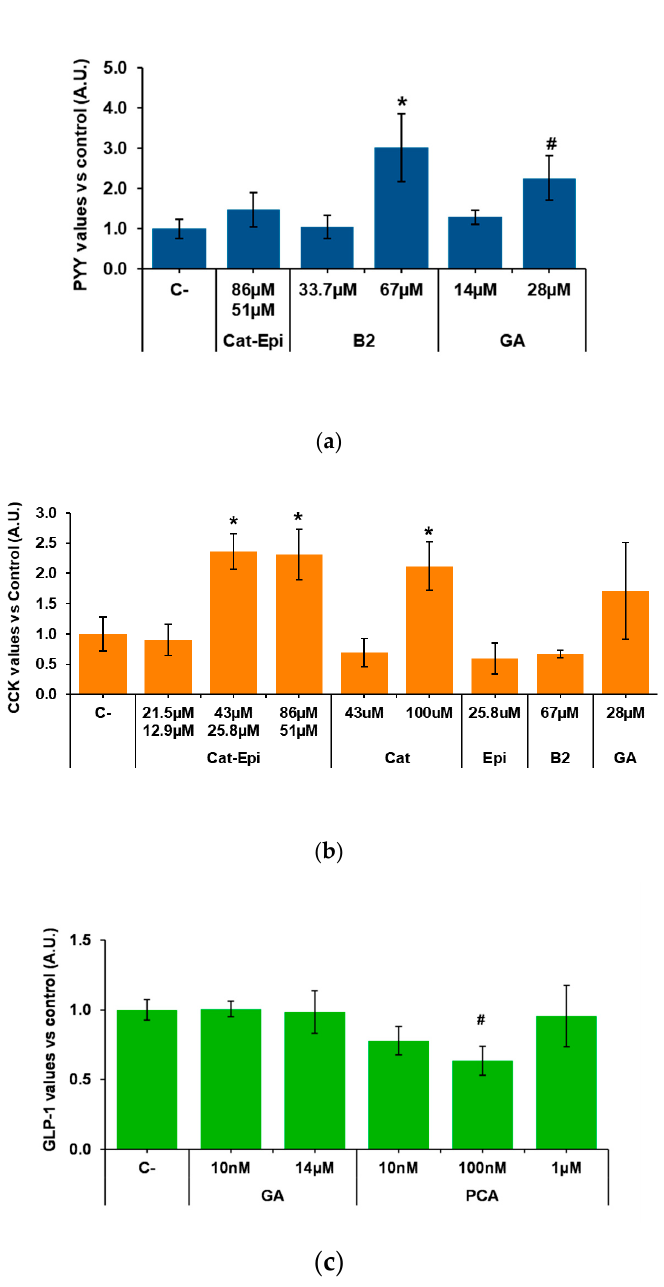
Figure 2. Enterohormone levels in the basolateral side after apical stimulation of pig intestinal samples with different purified compounds, for 60 min. ( a ) PYY secretion in the duodenum, ( b ) CCK secretion in the duodenum, ( c ) GLP-1 secretion in the ascending colon. Results are expressed in arbitrary units (A.U.), which are values normalized versus the control and represent mean ± SEM. * p < 0.05 vs. control, # p < 0.1, t -test. n = 7–9. C-, negative control vehicle-treated; Cat, catechin; Epi, epicatechin; B2, B2 procyanidin dimer; GA, gallic acid; PCA, protocatechuic acid.